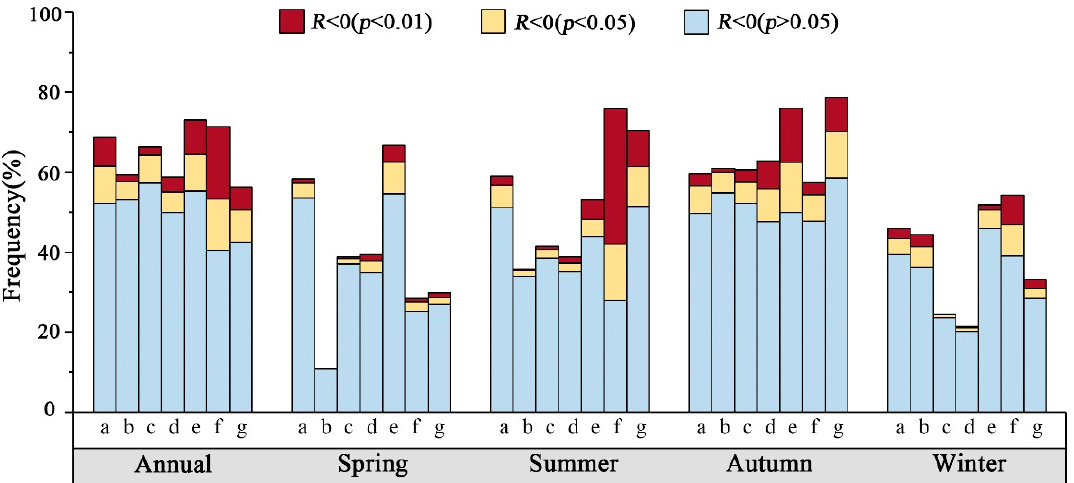
Figure 8. Frequency distribution of the areas with negative correlation ( R < 0) between gross primary productivity (GPP) and vapor pressure deficit (VPD) for different vegetation types (a) evergreen forests, (b) deciduous forests, (c) mixed forests, (d) woody savannas, (e) savannas, (f) grasslands, and (g) croplands under different temporal scales (annual and seasonal) across China from 2001 to 2020.